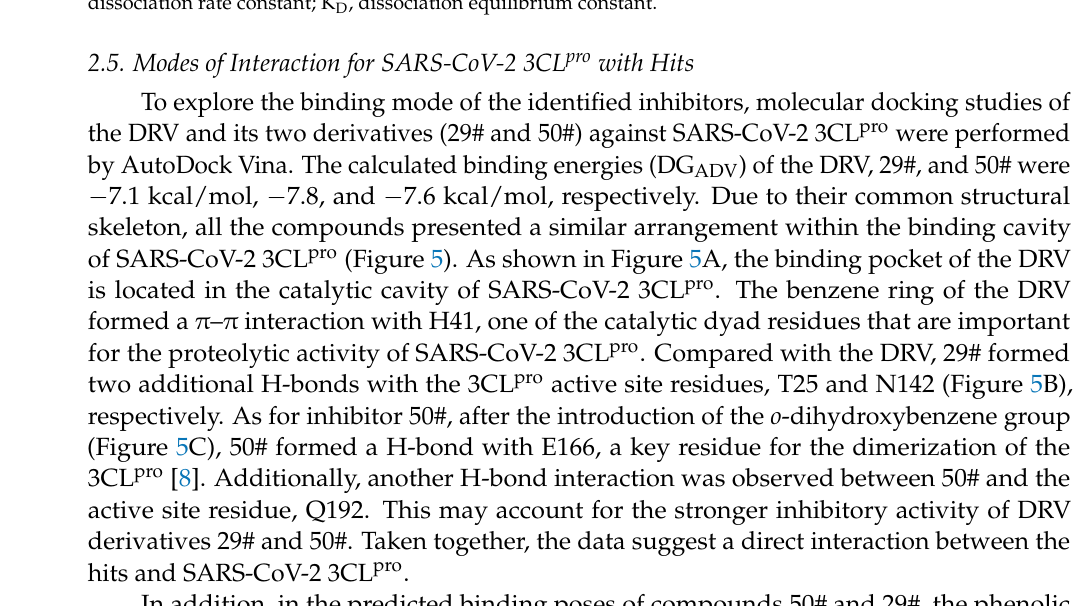
Table 2. Kinetics of 29# and 50# binding to the 3CL pro in the ForteBio’s Octet System. Ligand (3CL pro ) Analyte